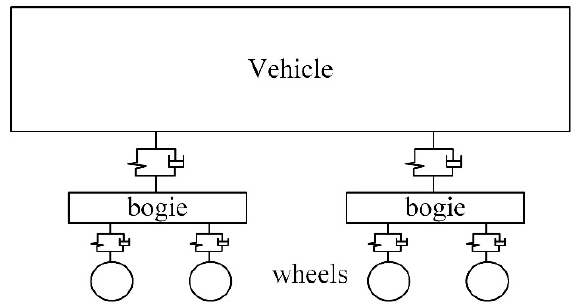
Figure 5. The schematic diagram of vehicle system dynamics model. Table 1. Parameters used in simulation.